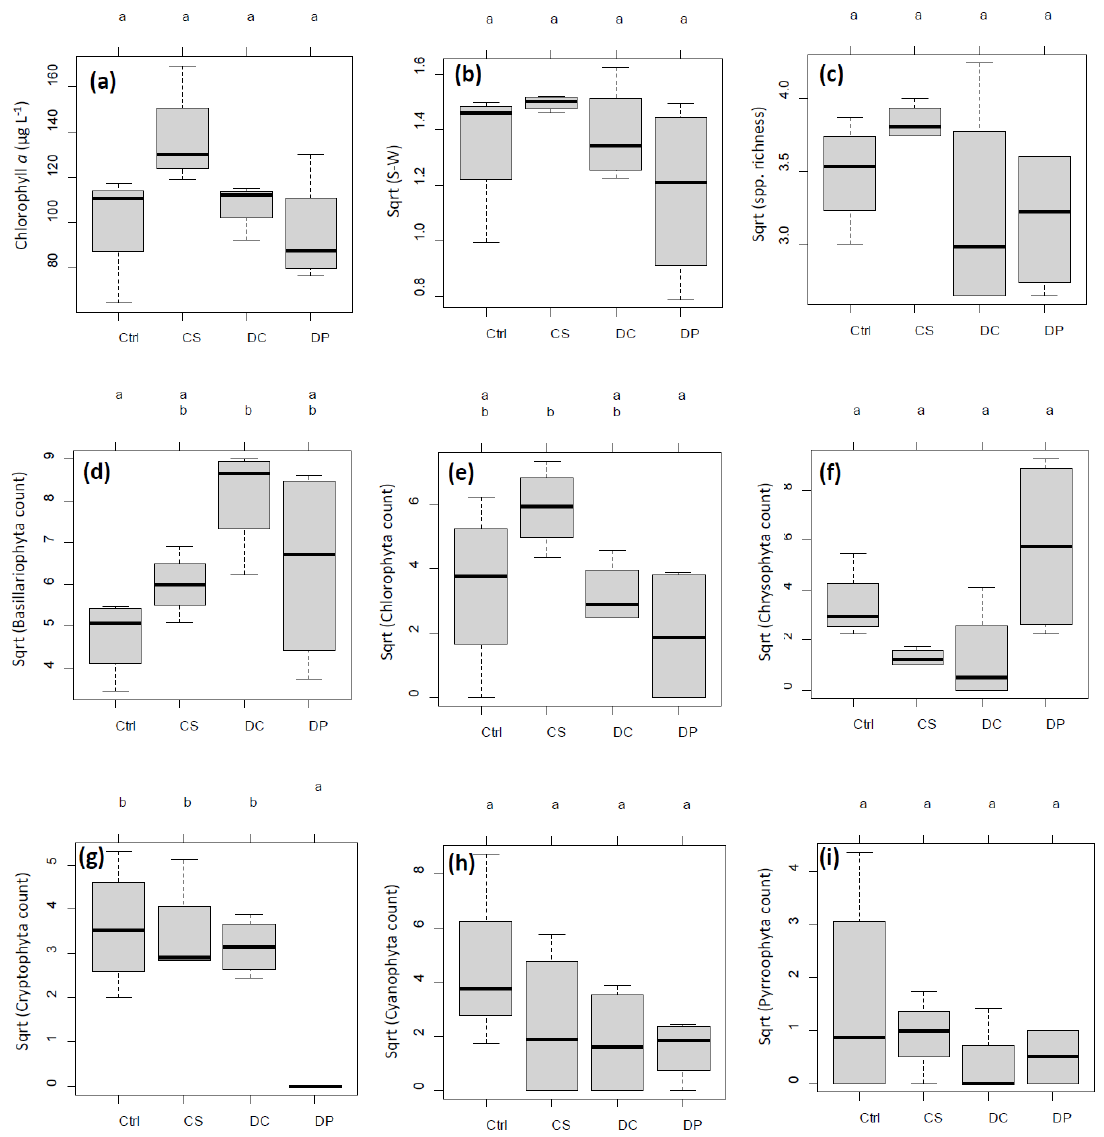
Figure 4. Boxplots of major experimental responses after a 7-day incubation by treatment groups. n = 4 each for control (Ctrl), plant particles (CS), calibration beads (DC), and body wash MPs (DP), except chlorophyll a (chl. a ) for DC (n = 3 due to sample loss). All responses except chl. a were square-root (sqrt) transformed to better meet model assumptions. Letters a and b on top of each panel indicate groupings by the results of multiple pairwise comparisons among the treatment groups by Tukey’s honestly significant difference (HSD) test at α = 0.05. ( a ) chl. a (µg L −1 ), ( b ) Shannon–Wiener (SW) index, ( c ) species richness, ( d ) Bacillariophyta count, ( e ) Chlorophyta count, ( f ) Chrysophyta count, ( g ) Cryptophyta count, ( h ) Cyanophyta count, and ( i ) Pyrrophyta count.